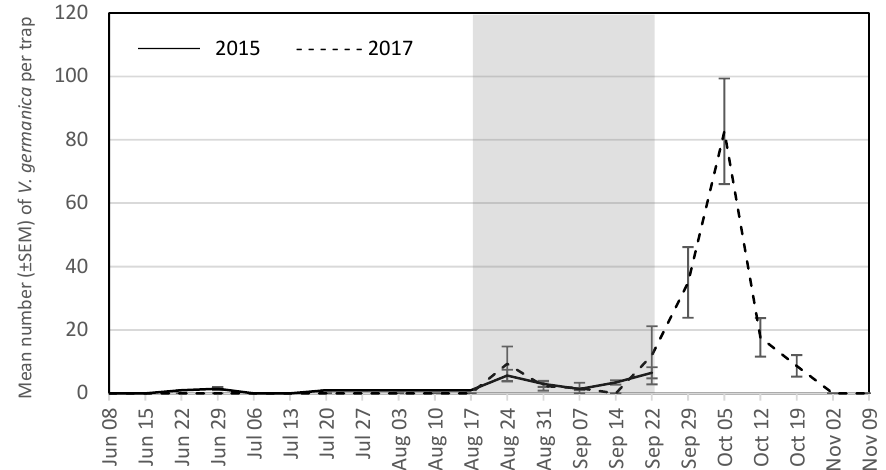
Figure 2. Mean number (±SEM) of Vespula germanica caught per trap per week in South Central Wisconsin vineyards in traps baited with acetic acid and isobutanol (AAIB) from 8 June to 22 September 2015 (solid line) and from 8 June to 9 November 2017 (dashed line). The shaded region indicates the overall grape harvest for all grape cultivars present across all vineyards sampled.